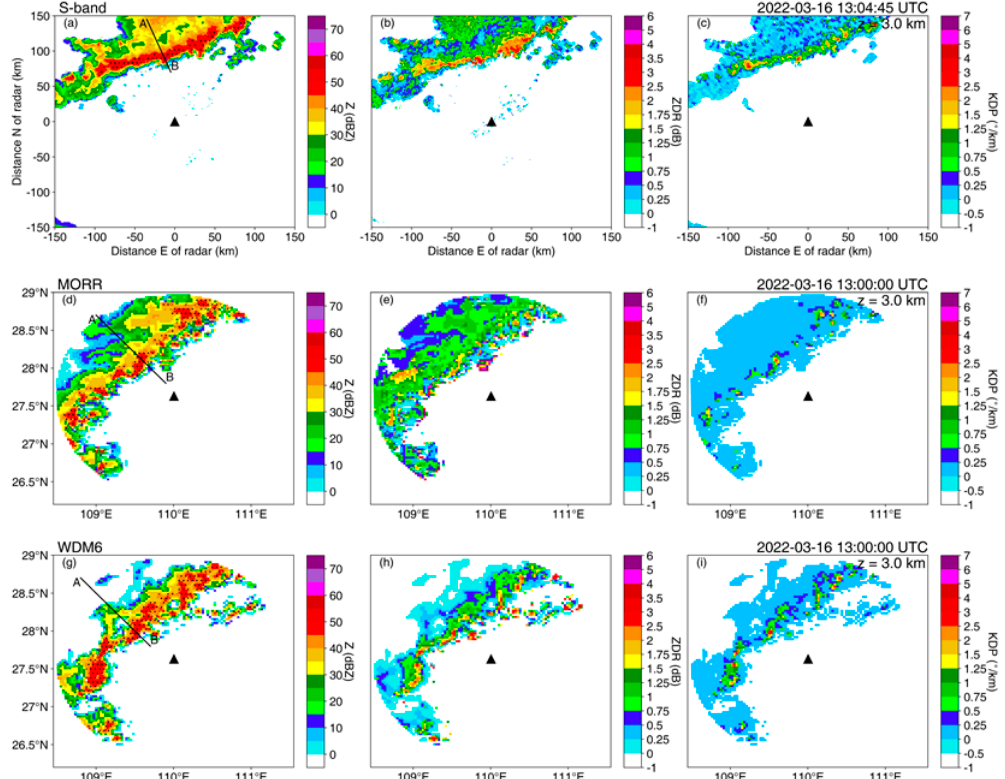
Figure 7. ( a , d , g ) Radar reflectivity ( Z ; dBZ), ( b , e , h ) differential reflectivity ( Z DR ; dB), and ( c , f , i ) spe- cific differential phase ( K DP ; ◦ /km) from ( a − c ) the S-POL radar observations and the POLARRIS-f simulations converted from the WRF output using ( d – f ) MORR and ( g – i ) WDM6 microphysics schemes, at 1300 UTC on 16 March 2022 at an elevation of 3 km. The convective region was divided based on the criteria revised by Powell et al. [59] and is indicated by black dots. The triangle in each panel indicates where S-POL is situated. Lines A-B in (a), (d), and (g) indicate cross-section lines of Figure